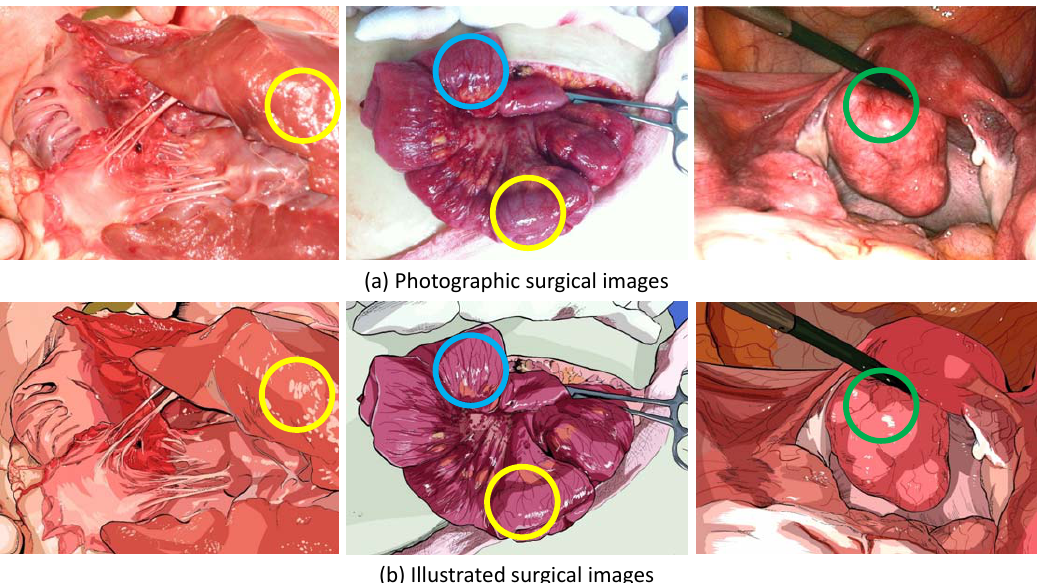
Figure 10. The marks drawn by a surgeon for the evaluation of the illustrated